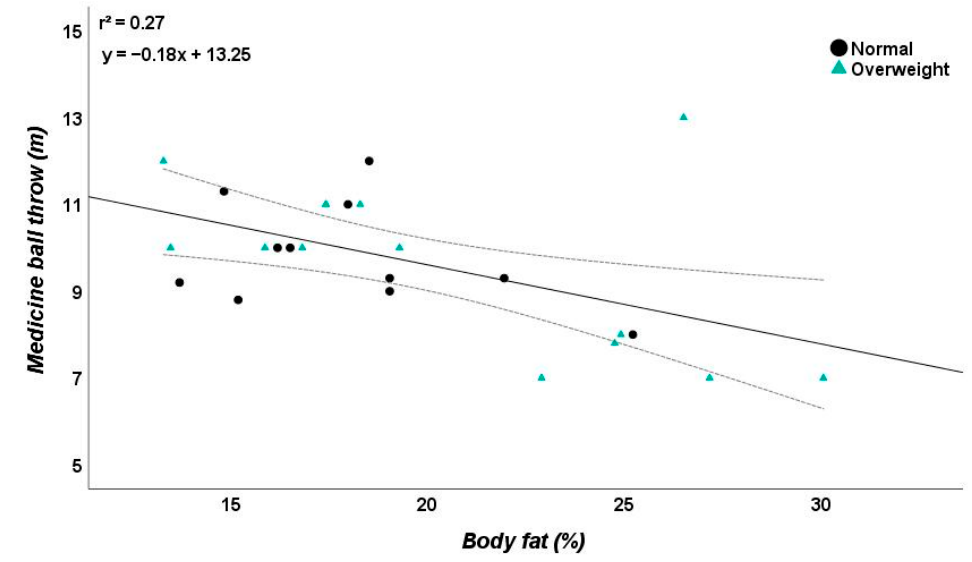
Figure 2. Relationship between body fat and aerobic capacity depending on the group. Please note that one dot can represent several subjects.